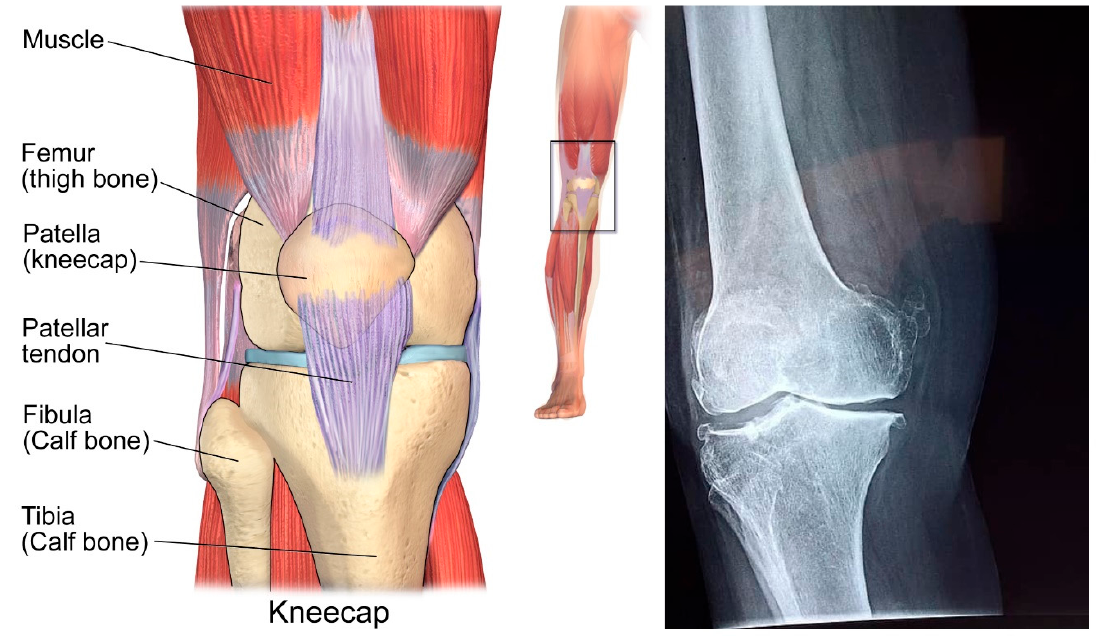
Figure 1. Structure of human knee.